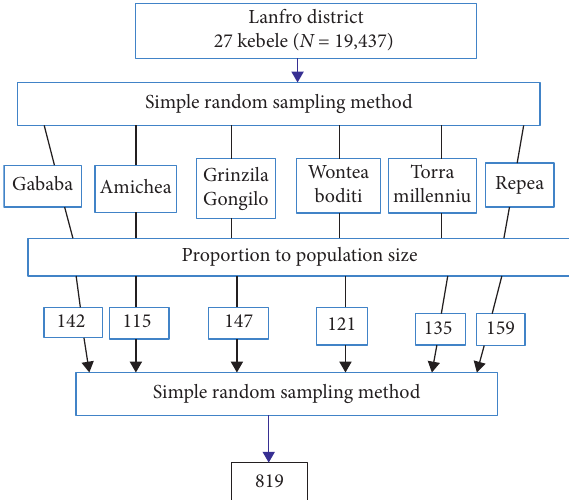
Figure 1: Schematic presentation of the sampling procedures on diagnostic concordance between RUAC and MUAC among chil- dren aged 6–59 months in south